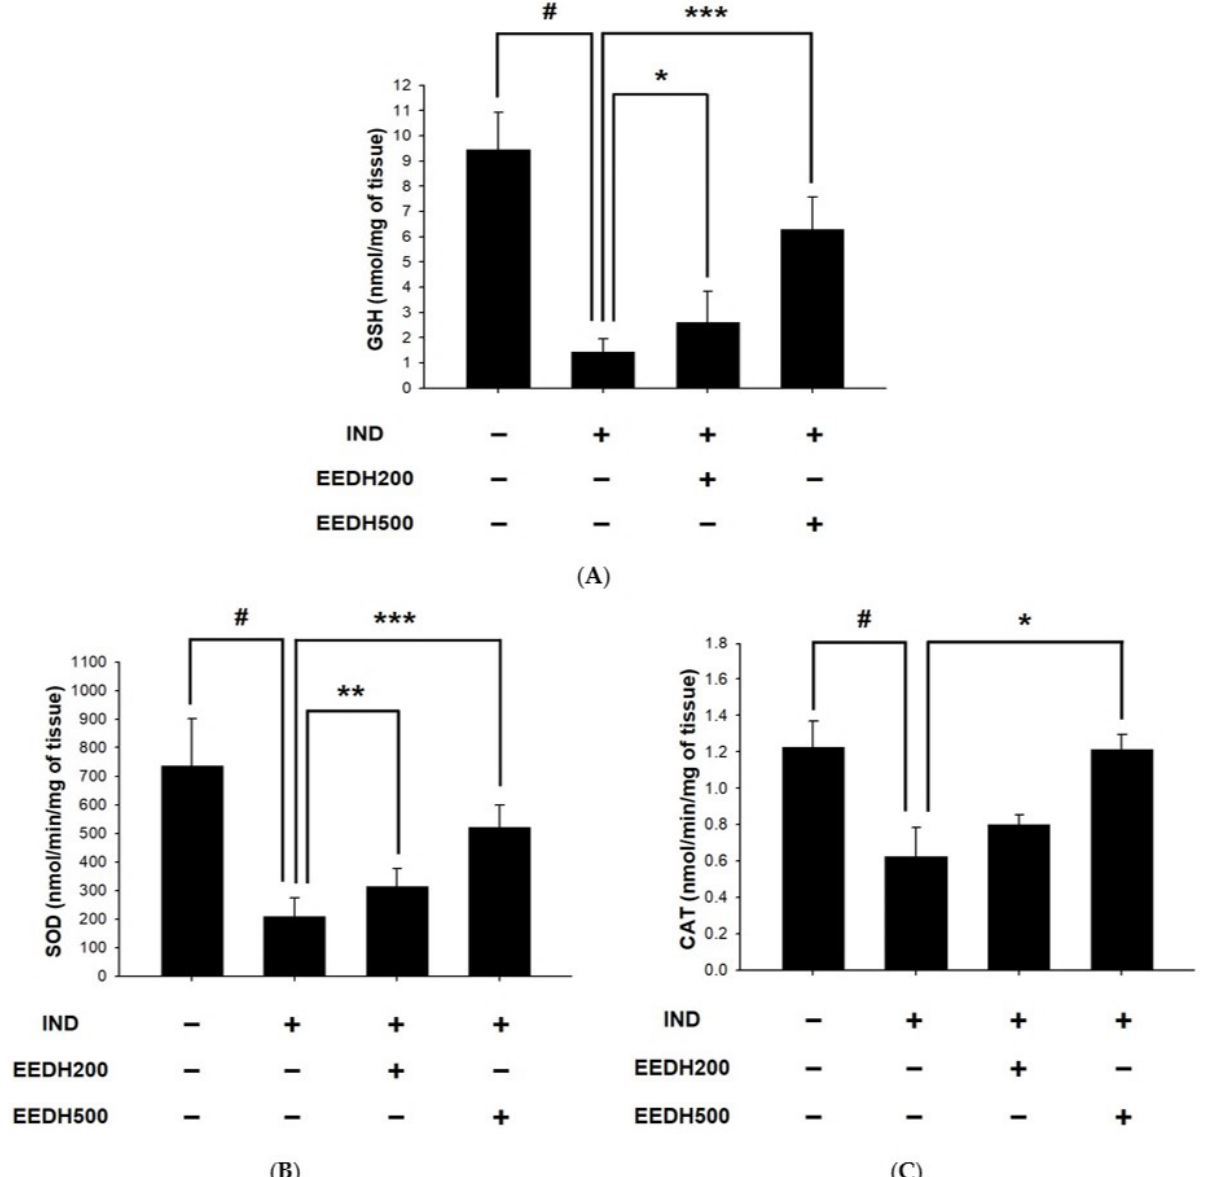
Figure 3. Effects of EEDH on ( A ) the level of GSH and ( B , C ) the activities of SOD and CAT of gastric mucosa in mice. Data are represented as means ± SD ( n = 8). # p < 0.05 compared with control group. * p < 0.05, ** p < 0.01, and *** p < 0.001 compared with IND-treated